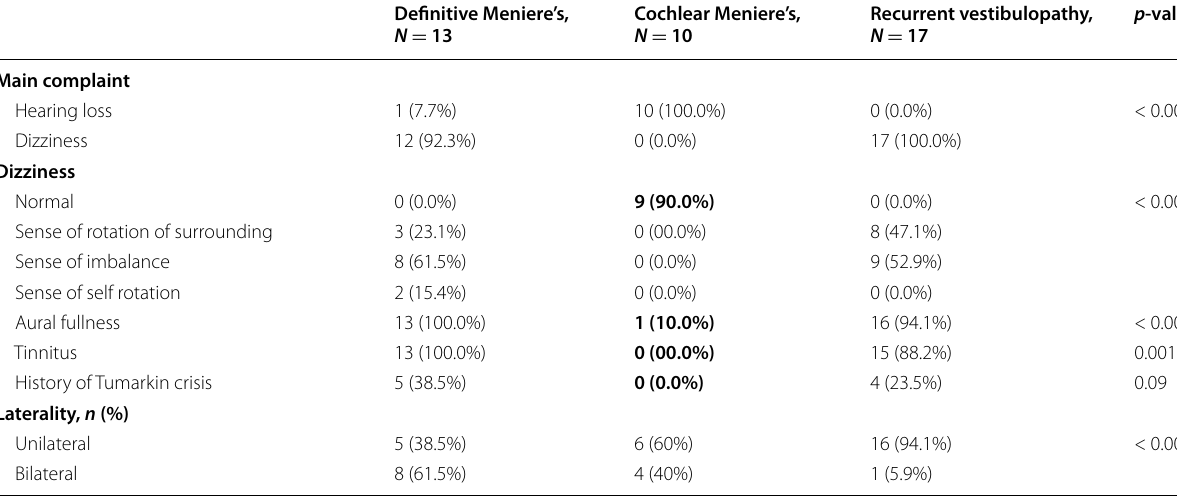
Table 2 Clinical characteristics of